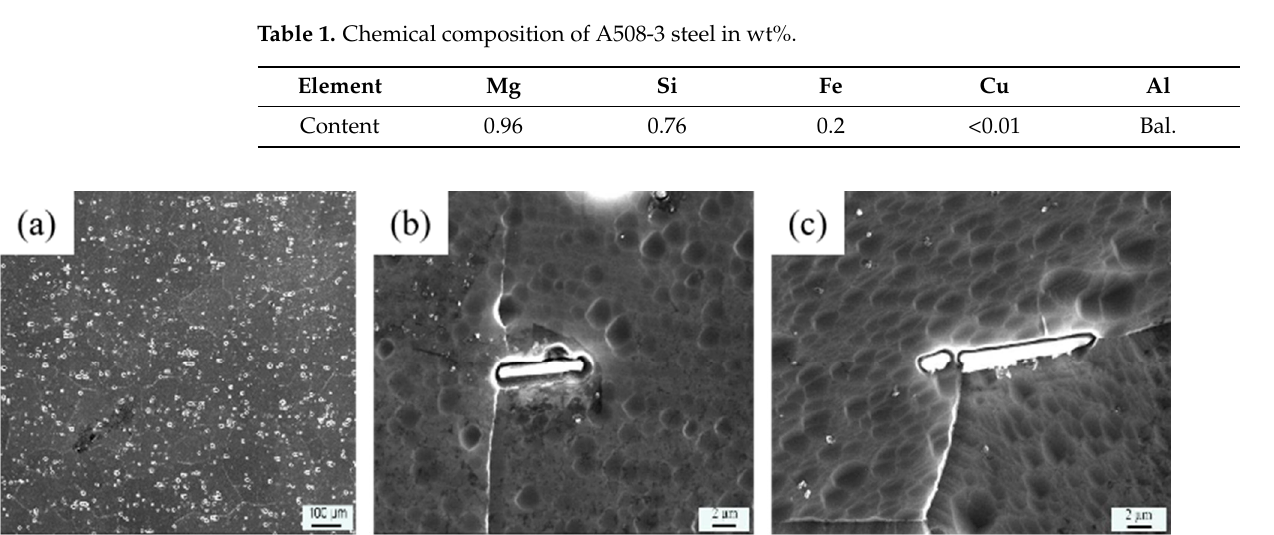
Figure 1. Metallograph of LT21 aluminum alloy: ( a ) Al matrix; ( b ) precipitate in the matrix; ( c ) pre- cipitate at the grain boundary. ( c ) precipitate at the grain